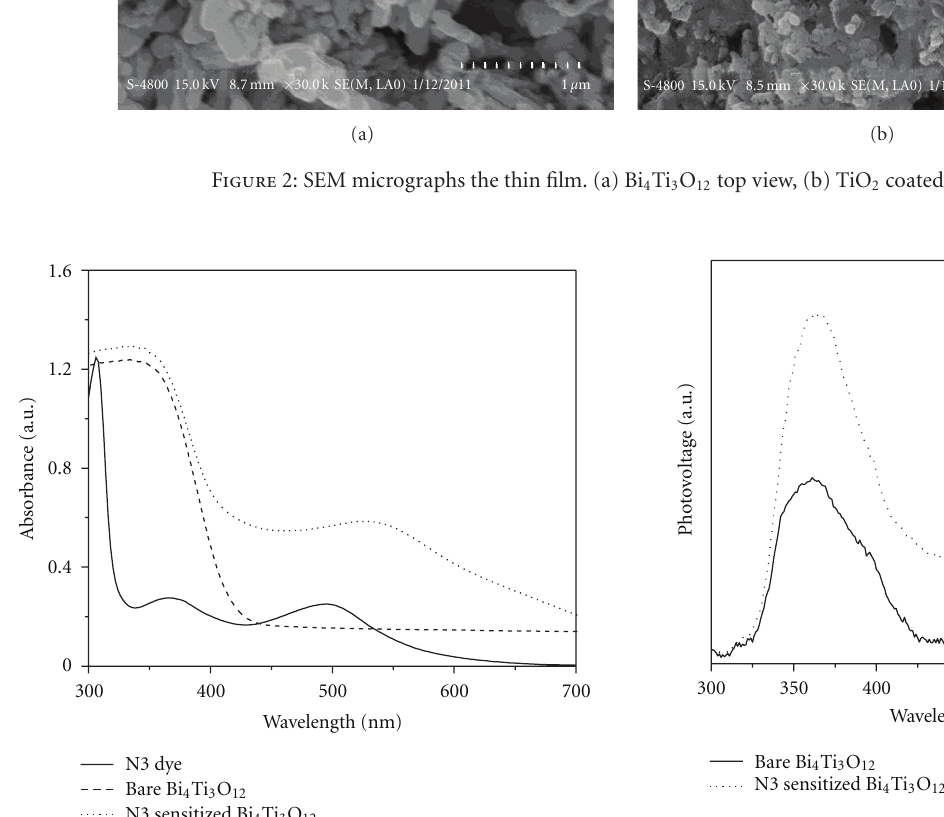
Figure 4: SPS spectra of Bi 4 Ti 3 O 12 nanoparticles (curve a) and N3- sensitized Bi 4 Ti 3 O 12 nanoparticles (curve